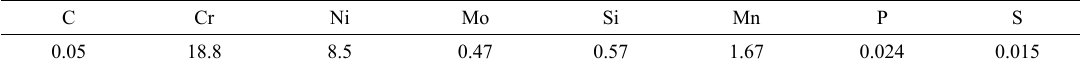
Table 1. Chemical composition of the AISI 304 steel.